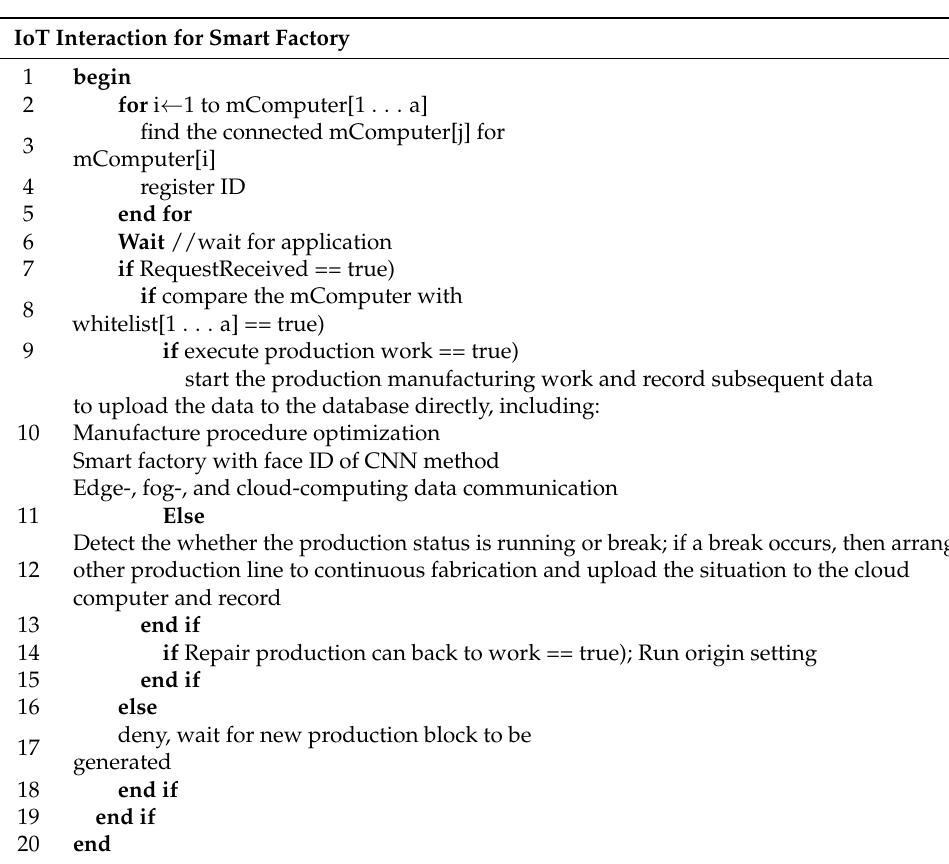
Table 1. IoT method for production line